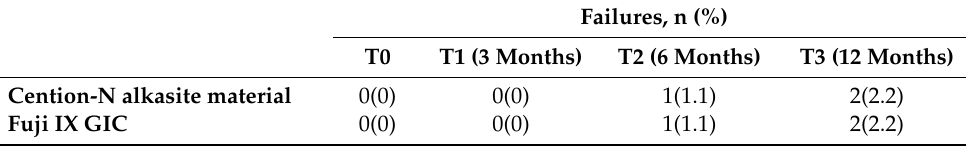
Table 2. Reported